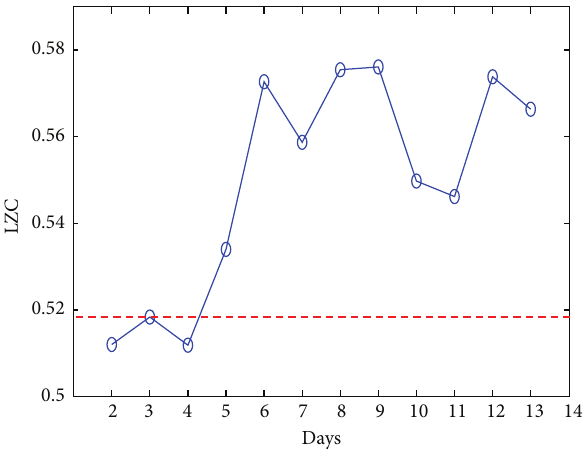
Figure 19: LZC value during the test for all days.